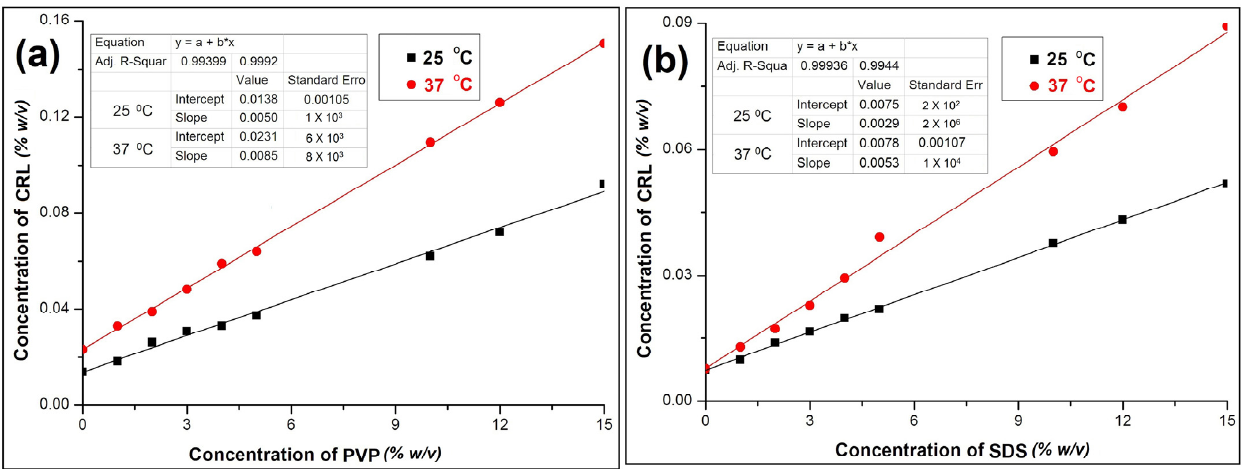
Figure 1. Phase solubility graph of ( a ) CRL-PVP, and ( b ) CRL-SDS.